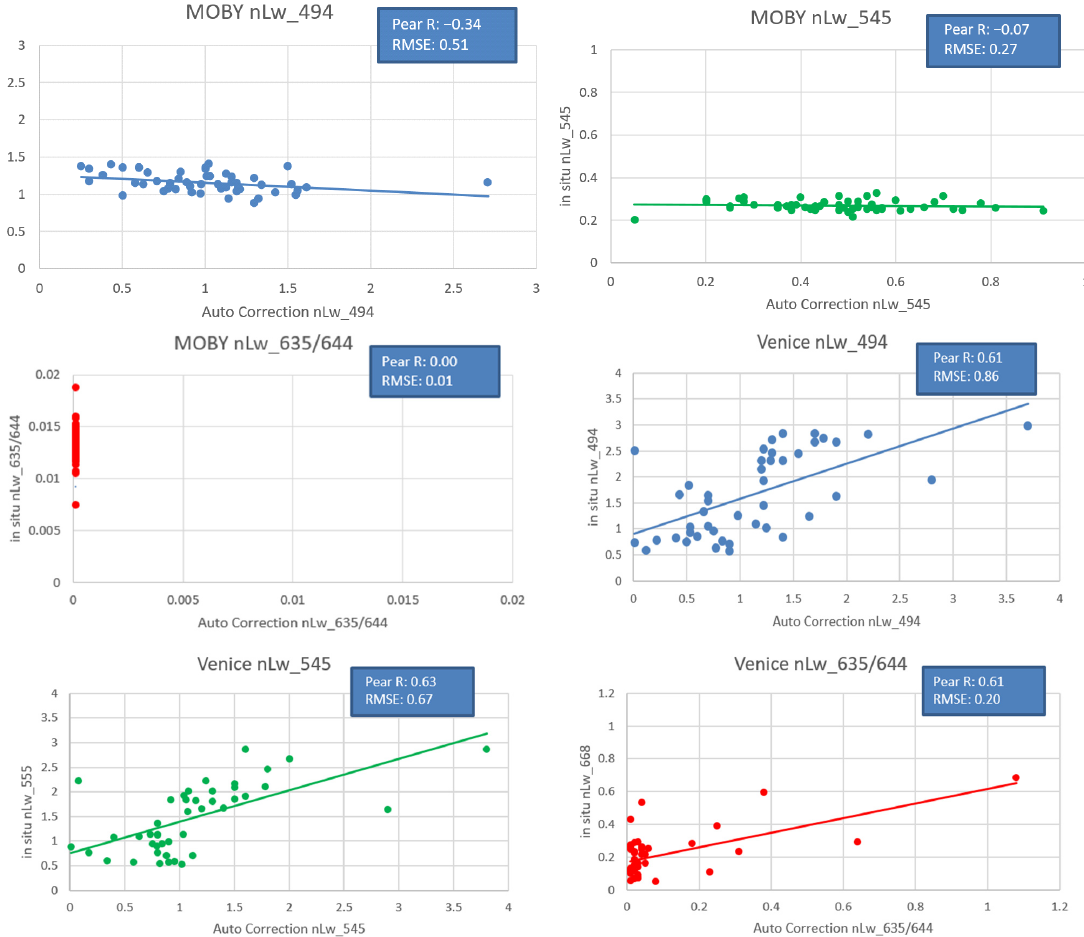
Figure 5. Gordon–Wang automated atmospheric correction using Planet PlanetScope’s duplicated red band and NIR band. Top left : MOBY nLw_494. Top right : MOBY nLw_545. Middle left : MOBY nLw_635/644. Middle right : Venice nLw_494. Bottom left : Venice nLw_545. Bottom right : Venice nLw_635/644.